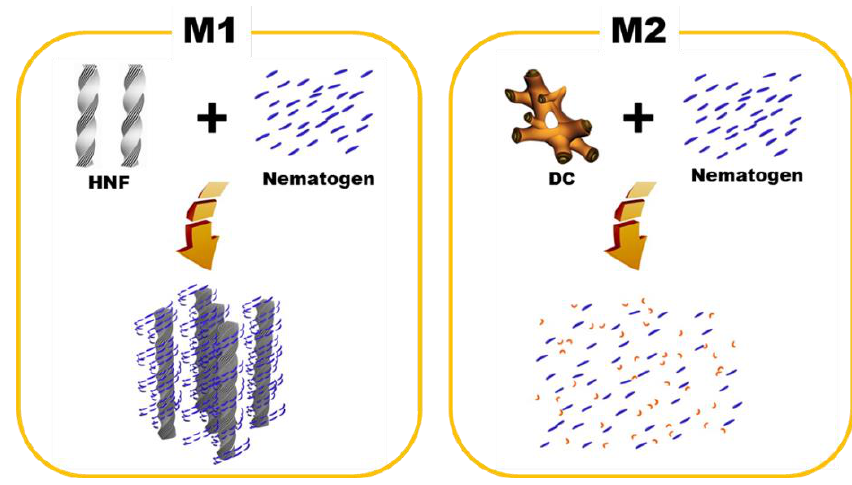
Figure 6. Schematics of the organization principles for M1 and